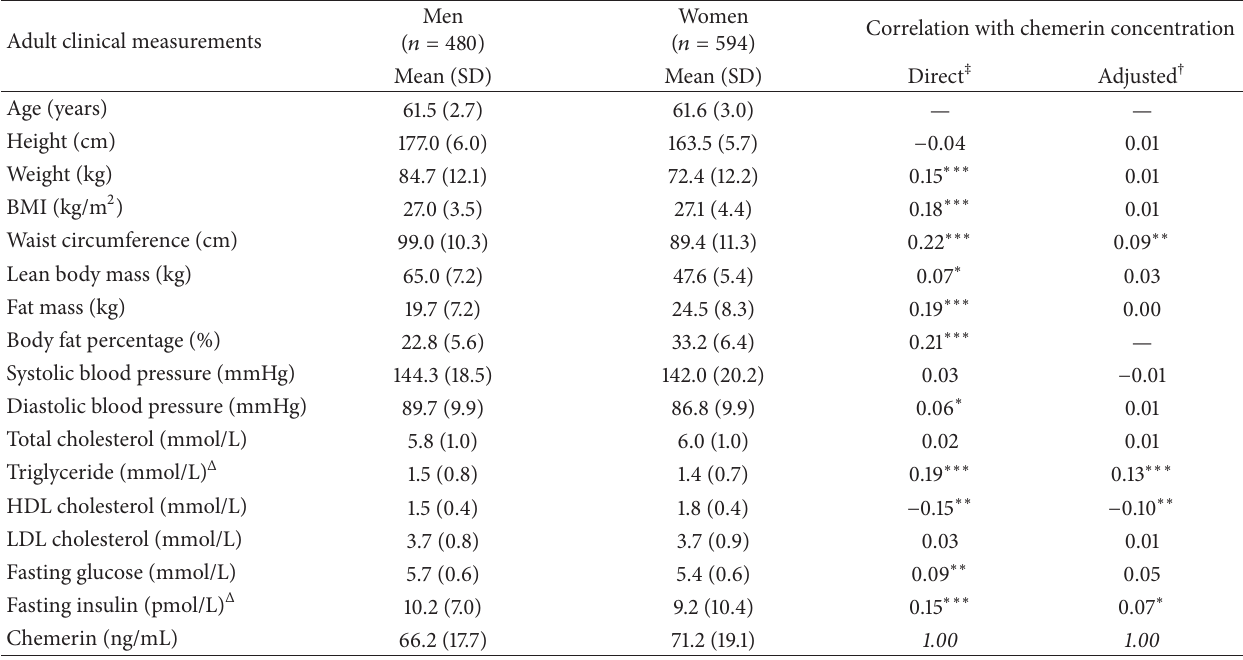
Table 1: Descriptive data for adult clinical measurements and correlations with chemerin